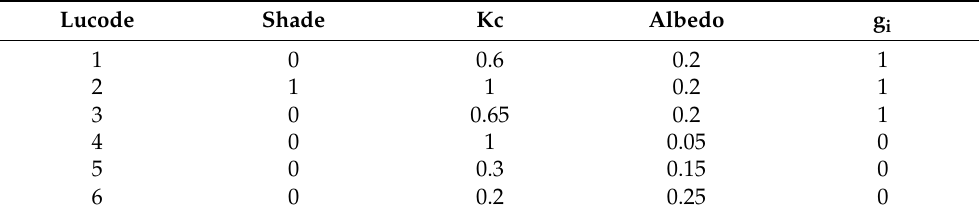
Table 5. HM coefficient